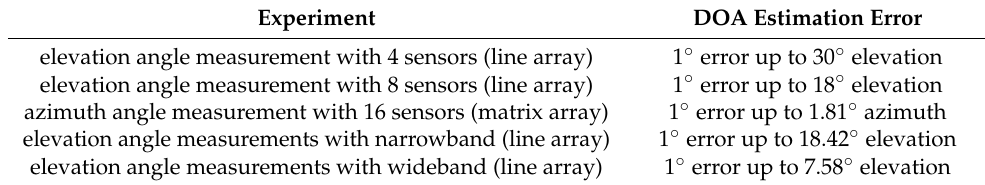
Table 2. Summary of the results.